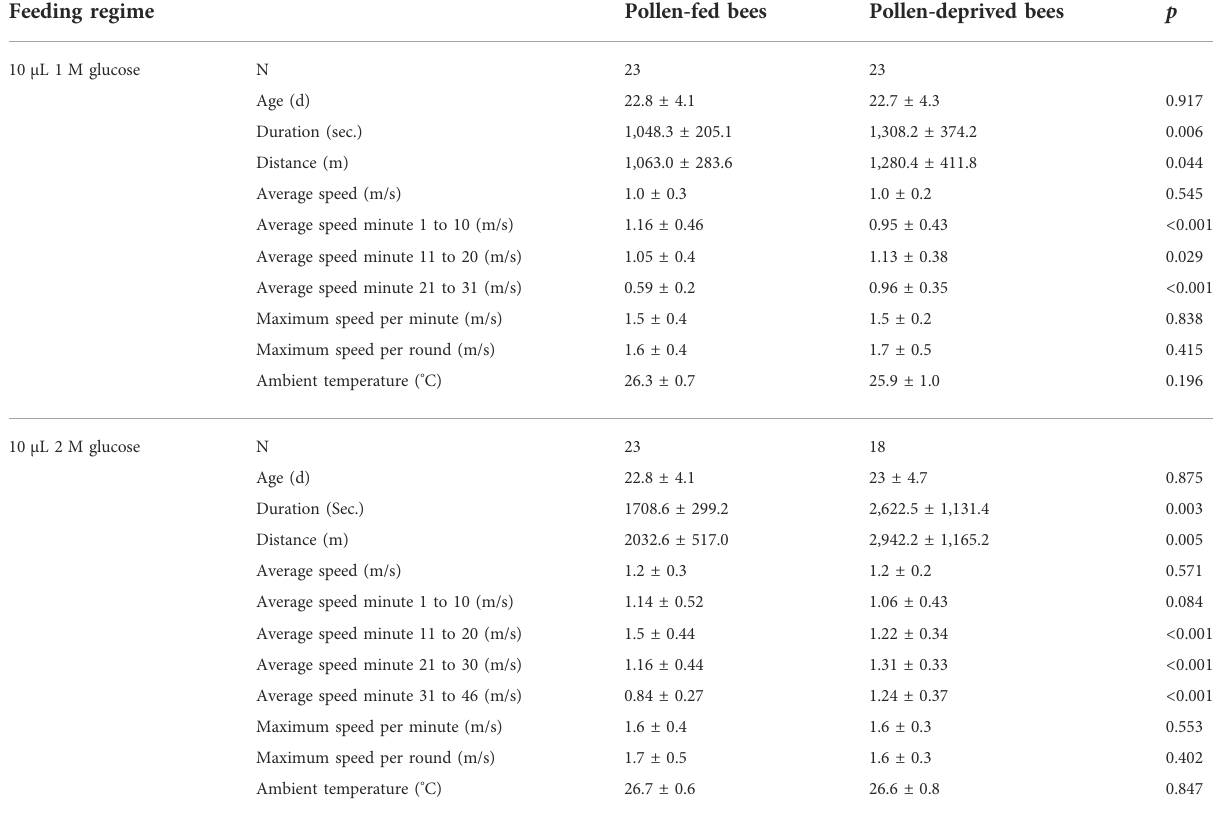
TABLE 1 Flight parameters of pollen-fed bees and pollen-deprived bees in two feeding regimes (10 μ L of 1 M glucose solution, 10 μ L of 2 M glucose solution). Feeding regime Pollen-fed bees Pollen-deprived